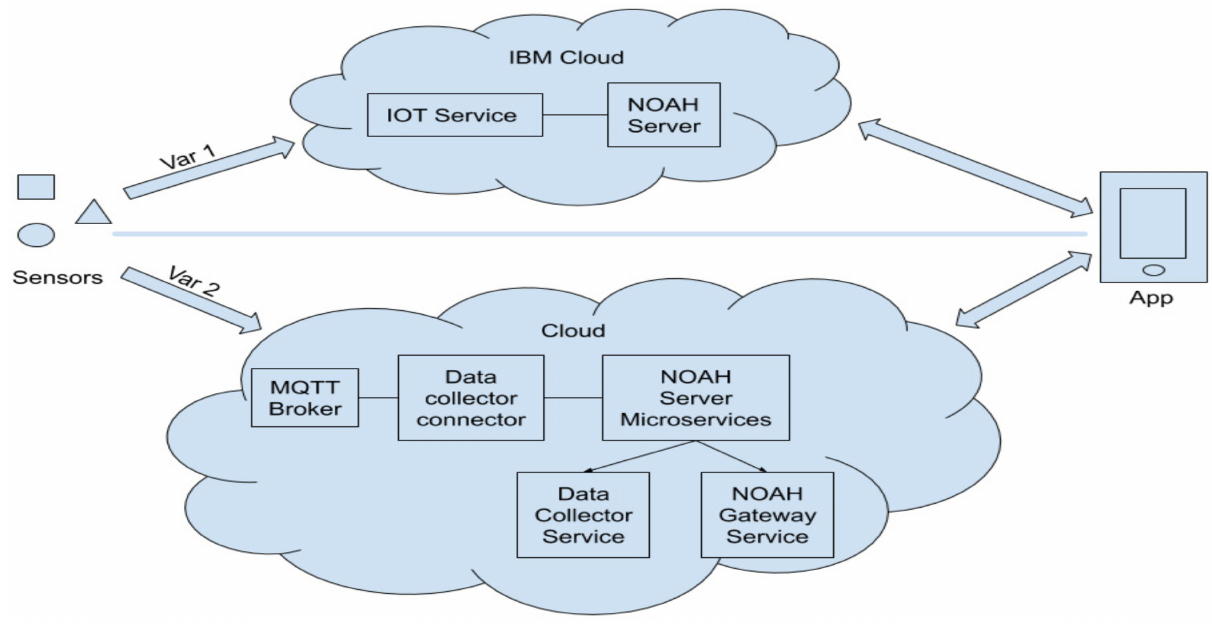
Figure 1. Architecture